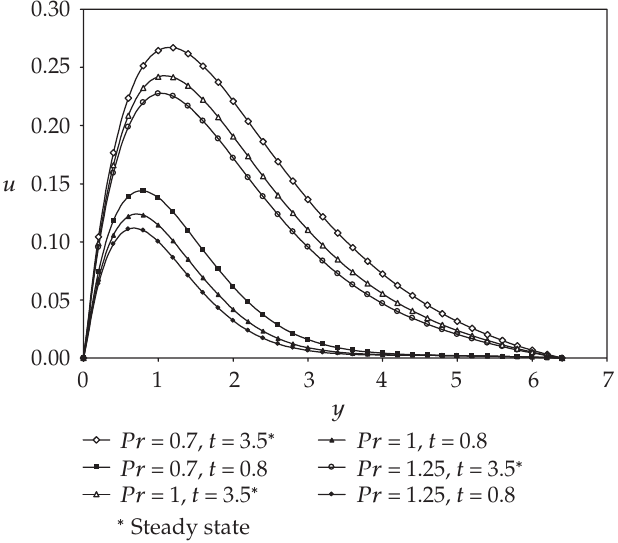
Figure 5.7 . Transient velocity profiles for the di ff erent values of Pr and the values x = 1, F = 0 . 01, m = 1, and M =